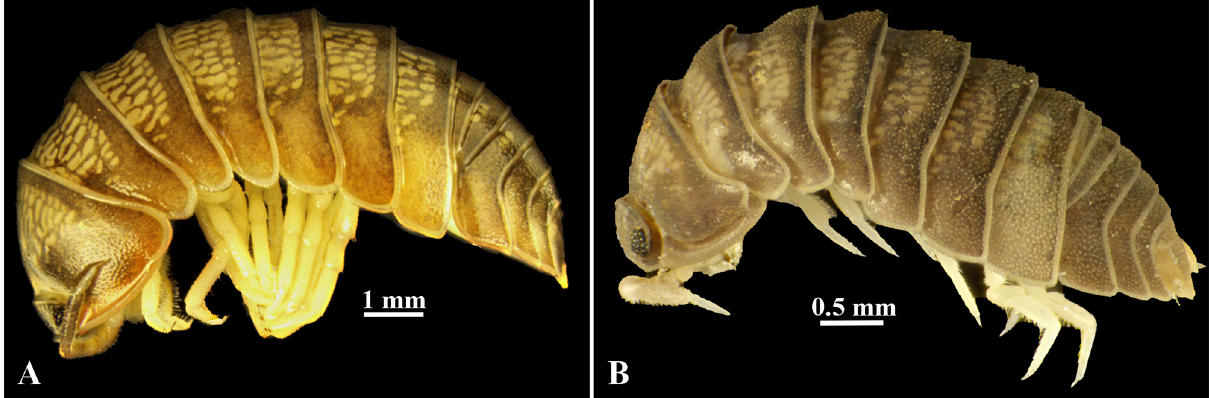
Figure 3. Habitus in lateral view of: A , Circoniscus ornatus (Verhoeff, 1941); B , Ethelum americanum (Dollfus,